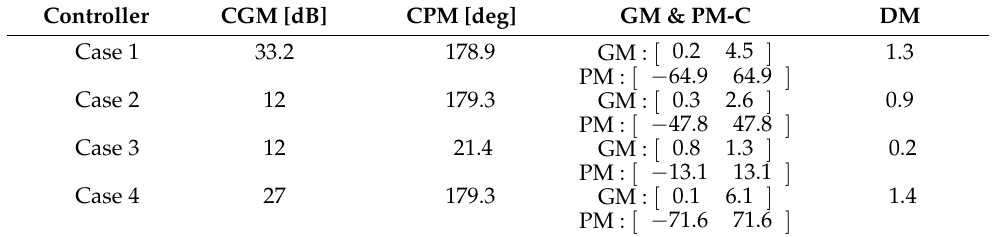
Table 4. Gain and phase disk margins for four different controller